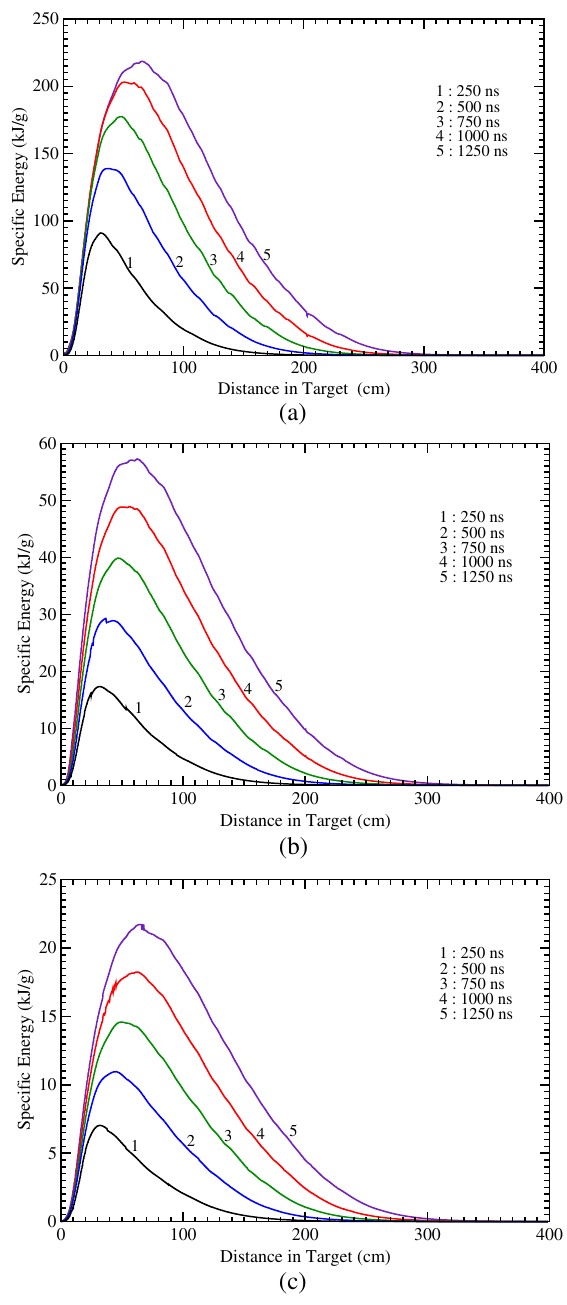
FIG. 3. Specific energy-deposition profiles vs distance in the target at different times: (a) along the axis at r ¼ 0 , (b) at r ¼ 1 mm, and (c) at r ¼ 2